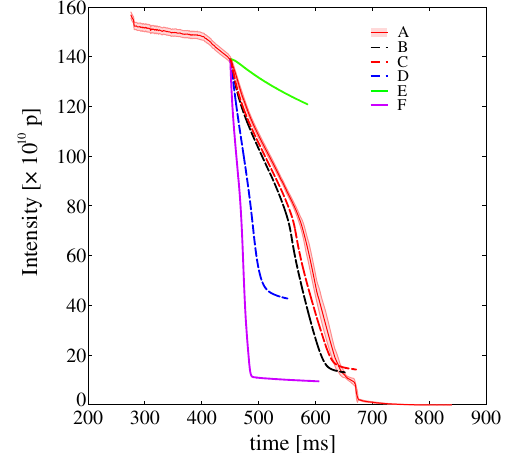
FIG. 9. Losses for different random errors. Legend: (A) Mea- surements; (B) Simulation with quadrupolar field and misalign- ment errors; (C) Simulation with only quadrupolar field errors (matching to Q y ¼ 4 . 525 ); (D) Simulation with only quadrupolar field errors (matching to Q y ¼ 4 . 535 ); (E) Simulation with random quadrupolar field errors and relative beta-beating ¼ 3 . 46% rms; (F) Simulation with random quadrupolar field errors and relative beta-beating ¼ 19 . 51% rms. All the simulations include SC.